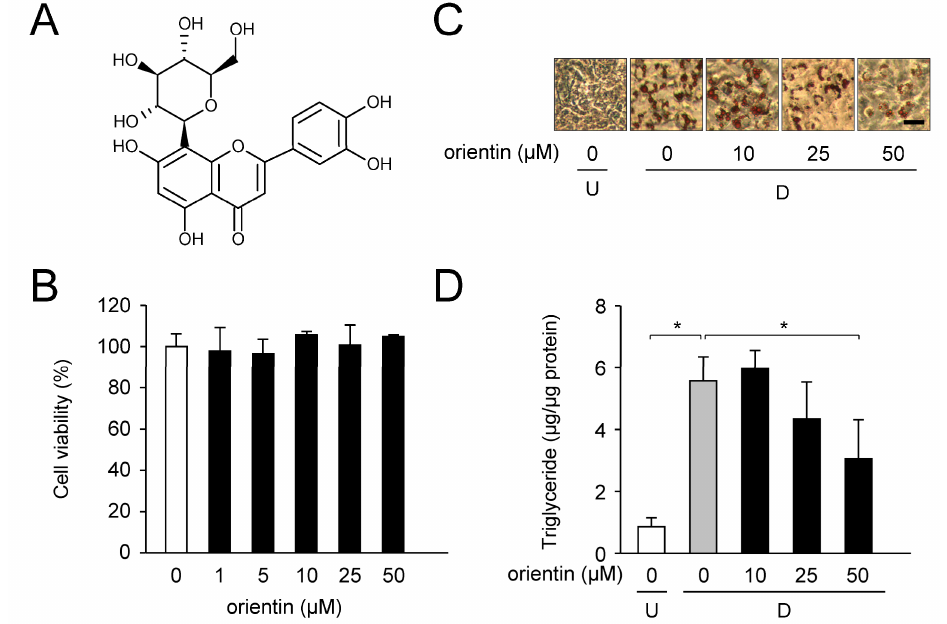
Figure 1. Decrease in accumulation of intracellular lipids by orientin. ( A ) Chemical structure of orientin; ( B ) Cytotoxicity of orientin in 3T3-L1 cells. Cell culture was performed for 6 days in medium including various concentrations of orientin (0–50 µ M). Cytotoxicity was measured by WST assay. Data are the means ± SD from three experiments; ( C ) Oil Red O staining of the lipid droplets in 3T3-L1 cells. The undifferentiated cells (U) were differentiated into adipocytes (D; for 6 days in medium with orientin (0–50 µ M). Bar = 50 µ m; ( D ) Change in intracellular triglyceride (TG) level in 3T3-L1 cells. Undifferentiated cells (U; 0 µ M orientin, white column) were caused to differentiate into adipocytes (( D ) 0 µ M orientin, gray column) for 6 days in medium containing orientin, (10, 25, or 50 µ M; black columns). Data are shown as the means ± SD from three experiments. * p < 0.01, as shown by the